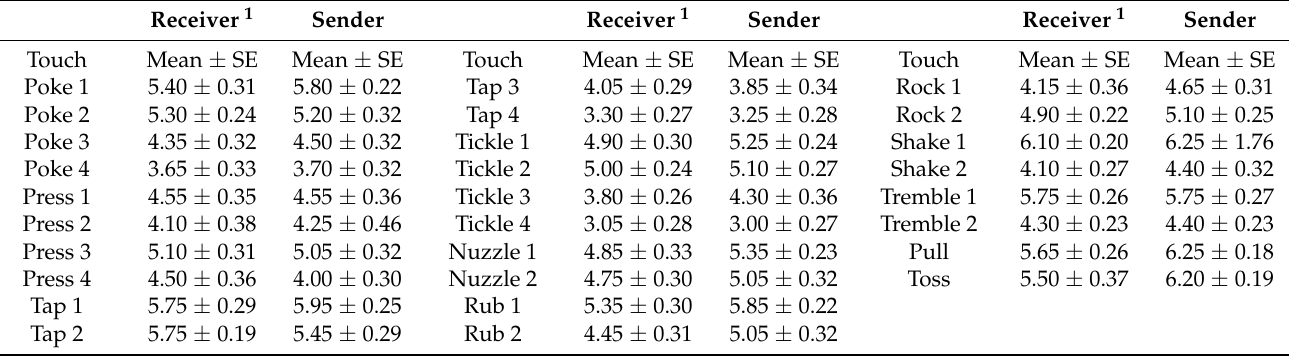
Table 3. Mean LUMST with vibrotactile stimuli.